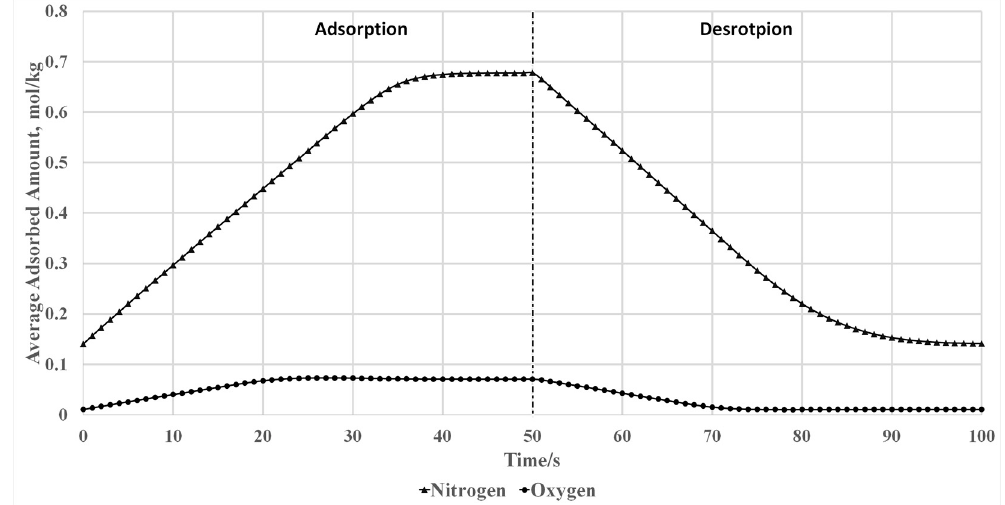
Figure 19. Simulation results of average adsorbed nitrogen and oxygen amount to the zeolite particles.